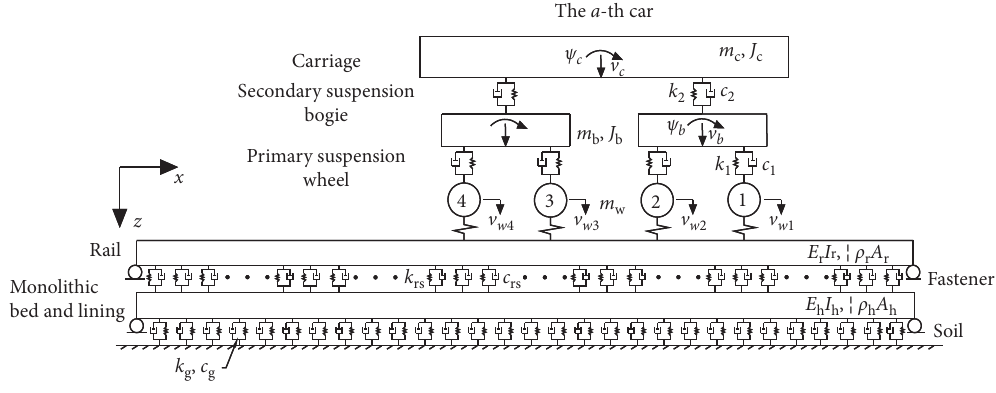
Figure 1: Model of a metro train-monolithic bed track